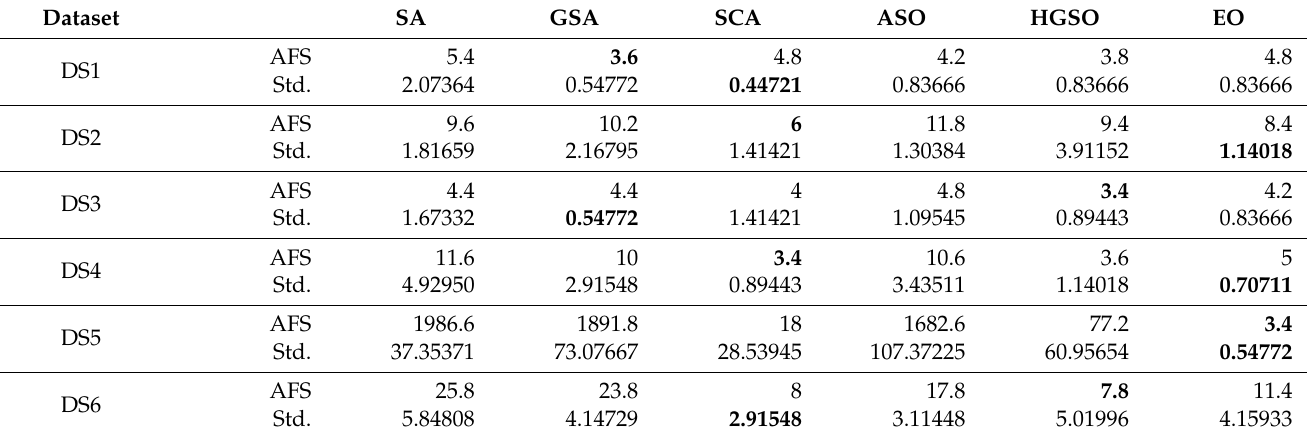
Table 5. Mean selected feature subsets of all algorithms and their standard